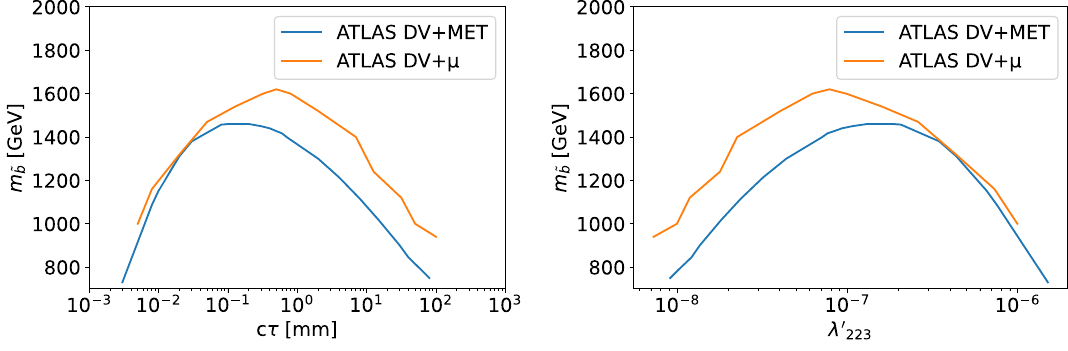
Fig. 6 Limits in the mass-lifetime (left) and mass- λ ( = λ (cid:6) The limits obtained with CheckMATE are presented